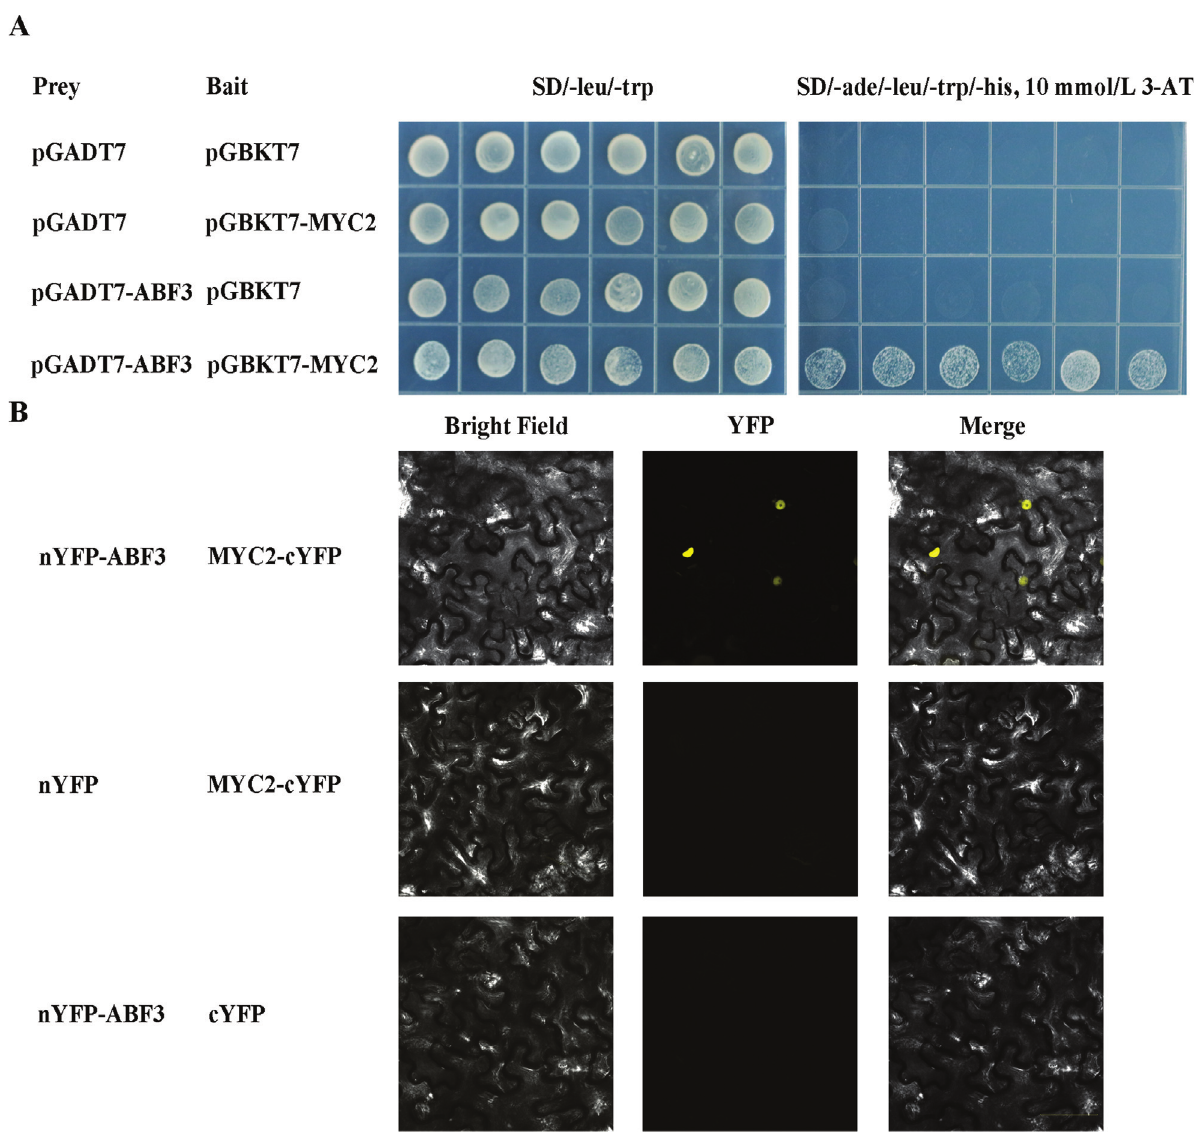
Figure 6 - MYC2 interacting with ABF3 in vivo. (A) Yeast two-hybrid assays for interaction between MYC2 and ABF3. The combinations of pGADT7 with pGBKT7, pGADT7 with pGBKT7-MYC2, and pGADT7-ABF3 with pGBKT7 were used as controls. 10 mM 3-AT was added to inhibit self-activationon4Dplates.Threereplicatingexperimentswereconducted,andsixdifferentcolonieswereinvestigatedforeachtypeofcombination.(B) BiFC assays for interaction between MYC2 and ABF3. Co-expressing nYFP-ABF3 and MYC2-cYFP, nYFP-ABF3 and cYFP, as well as MYC2-cYFP and nYFP in tobacco leaf epidermal cells. YFP signal intensity was detected from 48 h after infiltration. Scale bar: 50 (cid:2)